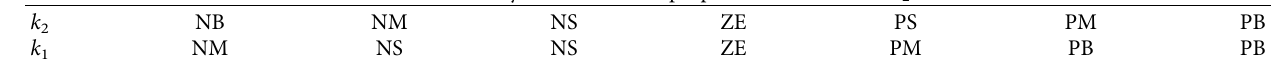
Table 2: Fuzzy control rule of proportional coefficient k